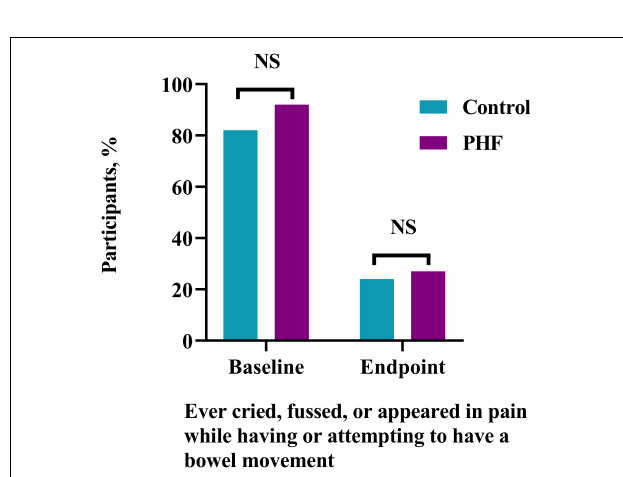
FIGURE 3 | Stool consistency scores over time. Means ( ± SD) for parent-reported stool consistency for 3-day diary intervals were plotted. Stool consistency scores for the first 3 diary days were compared by post hoc analysis. ∗ For Day 0 (Baseline), scores refer to the 3 days prior to Study Visit 1.